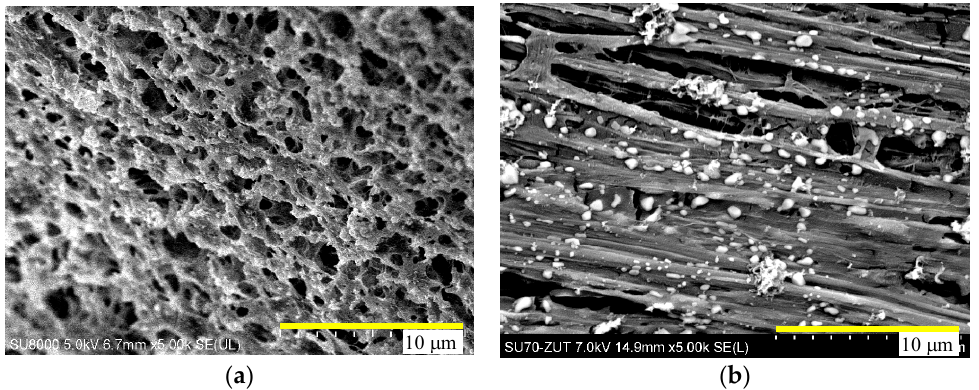
Figure 16. SEM images of membranes with deposit formed during separation of brackish water (T F = 318 K) by MD. ( a ) Module MK2—K1800 and ( b ) module MK3—EuroSep PP.